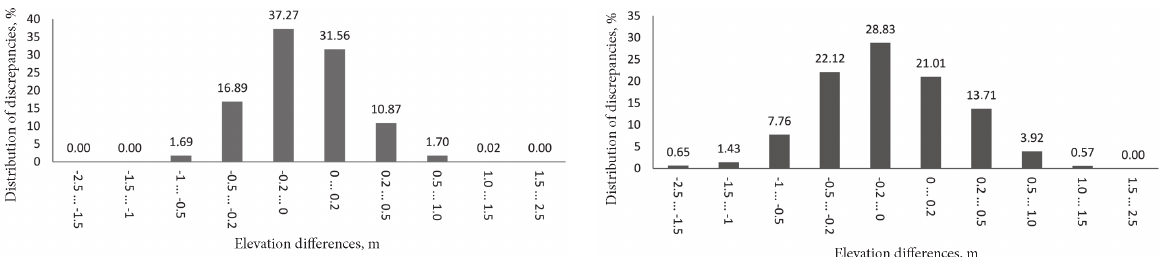
Fig. 9. Histogram illustrating the elevation discrepancies between TLS surface model and the 30 m step surface model